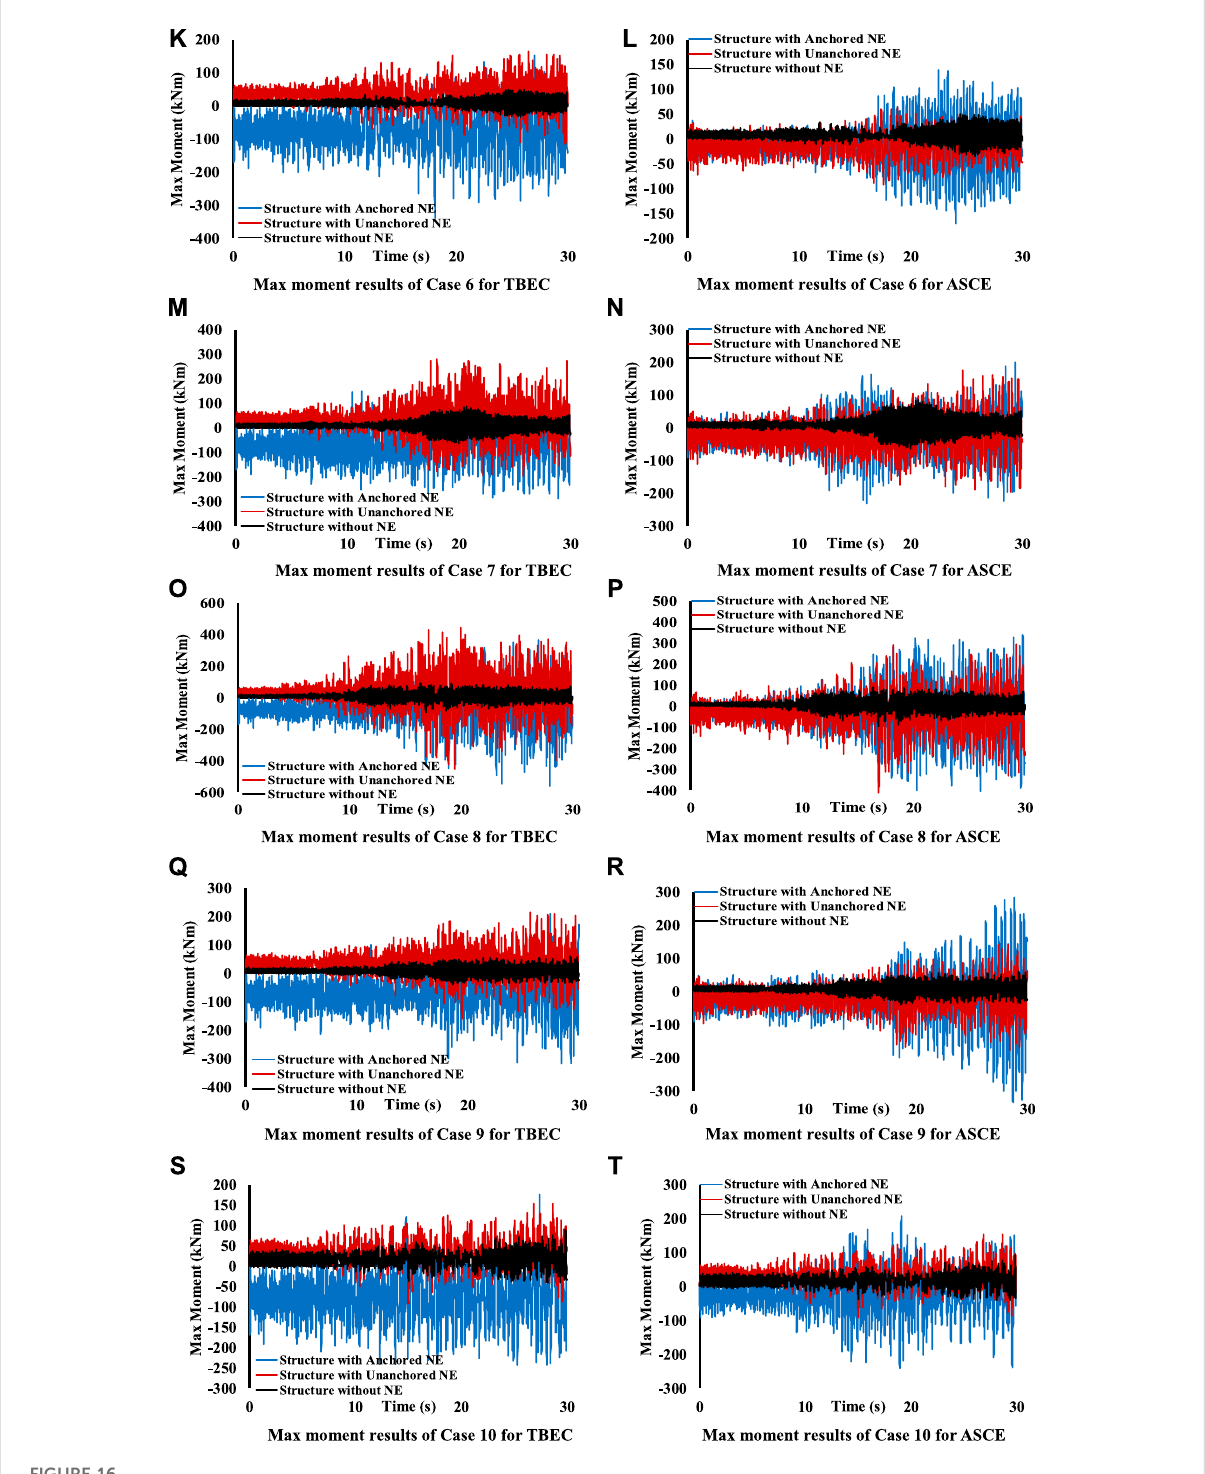
Max moment results for 10 various earthquake analyses